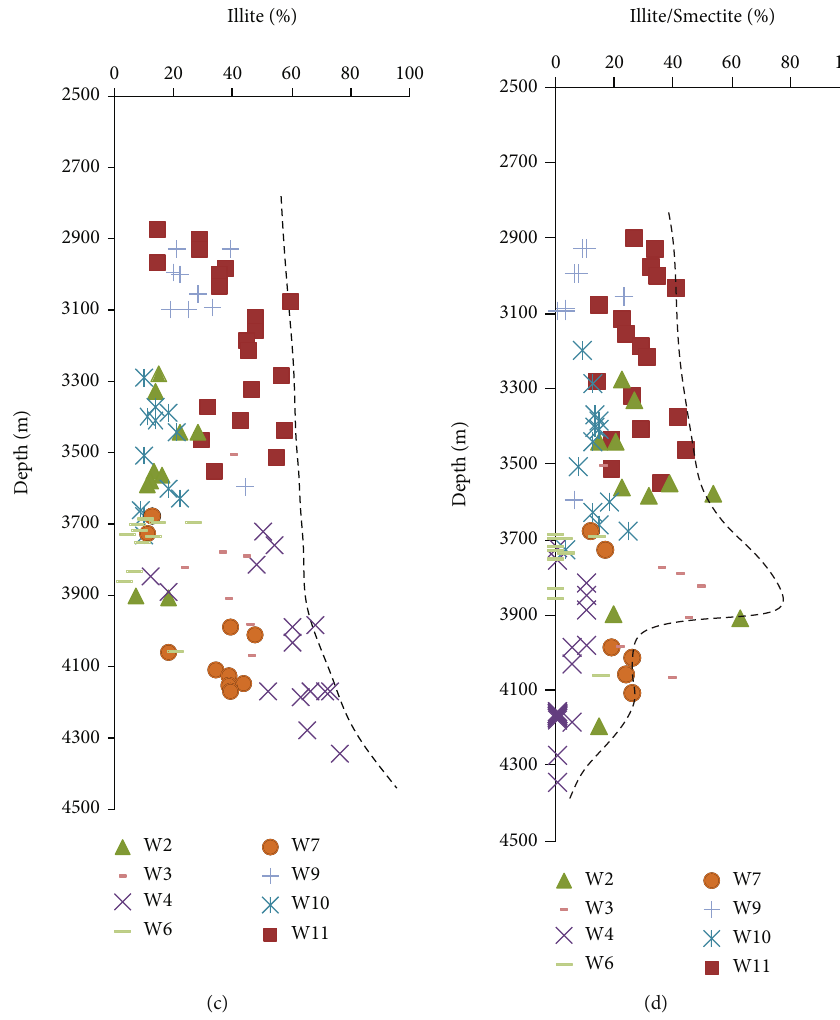
Figure 12: Variation of clay mineral content with depth obtained from XRD experiment. Table 2: The relative content of clay mineral cement. Mineral